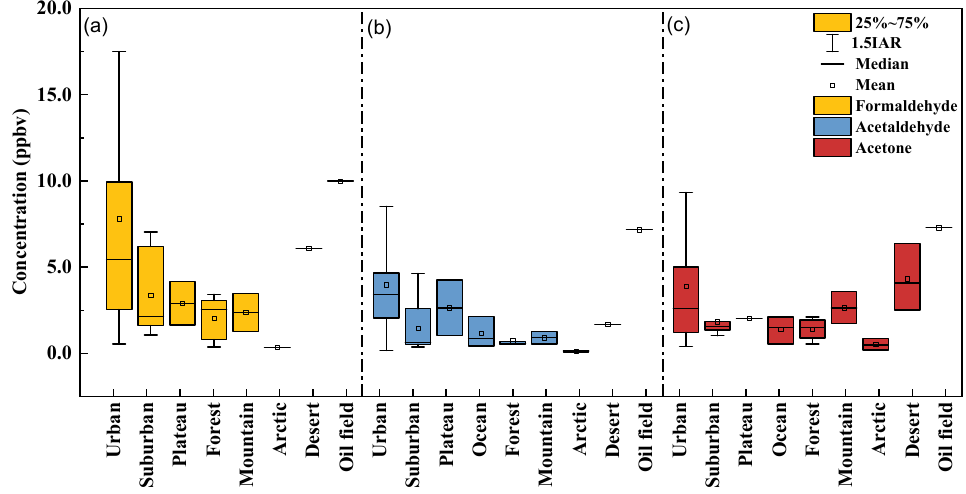
Figure 5. The average concentration of formaldehyde ( a ), acetaldehyde ( b ), and acetone ( c ) in various environments. See Table S3 for detailed information.